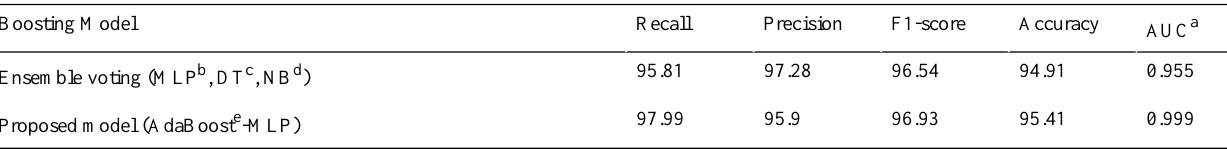
Table 6. Ensembling of deep-learning